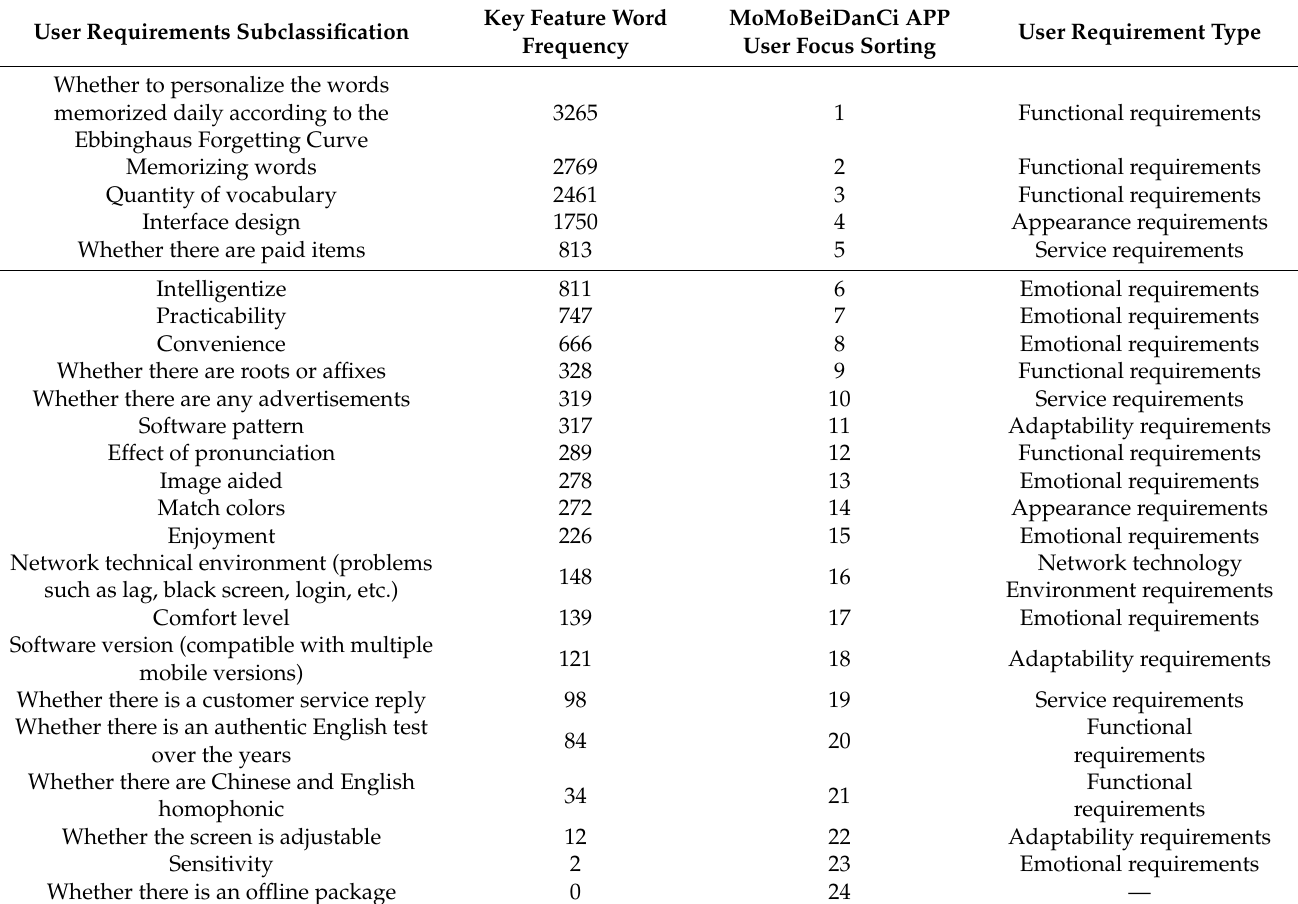
Table 9. MoMoBeiDanCi user requirement elements